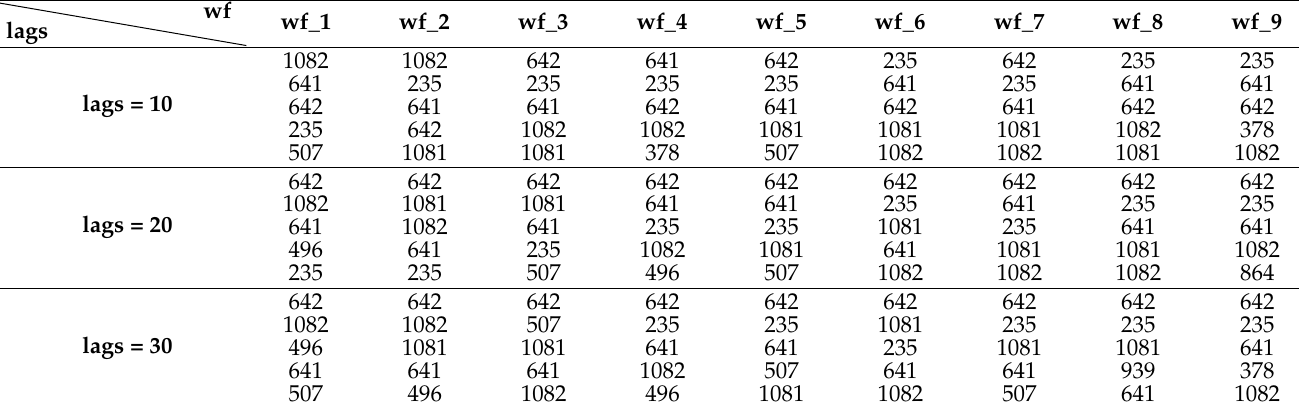
Table 3. The candidate weeks of the spring season in Colmenarejo Este presented for different sets of weighting factors and lag sizes.